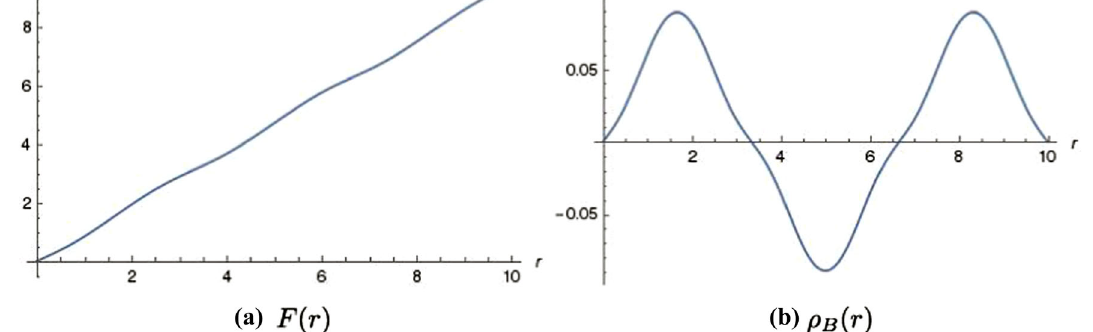
Fig. 7 Solution with n = 1